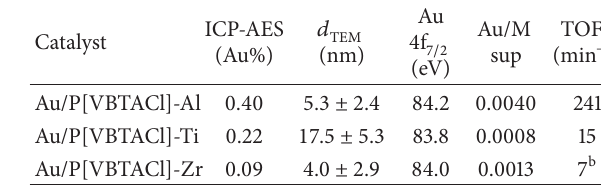
Table 4: ICP-AES, TEM mean Au sizes, XPS data after reaction, and TOF in the last cycle of Au/P[BVTACl]-M catalysts in the p- CNB hydrogenation. Reactions conditions: solvent, 25 mL